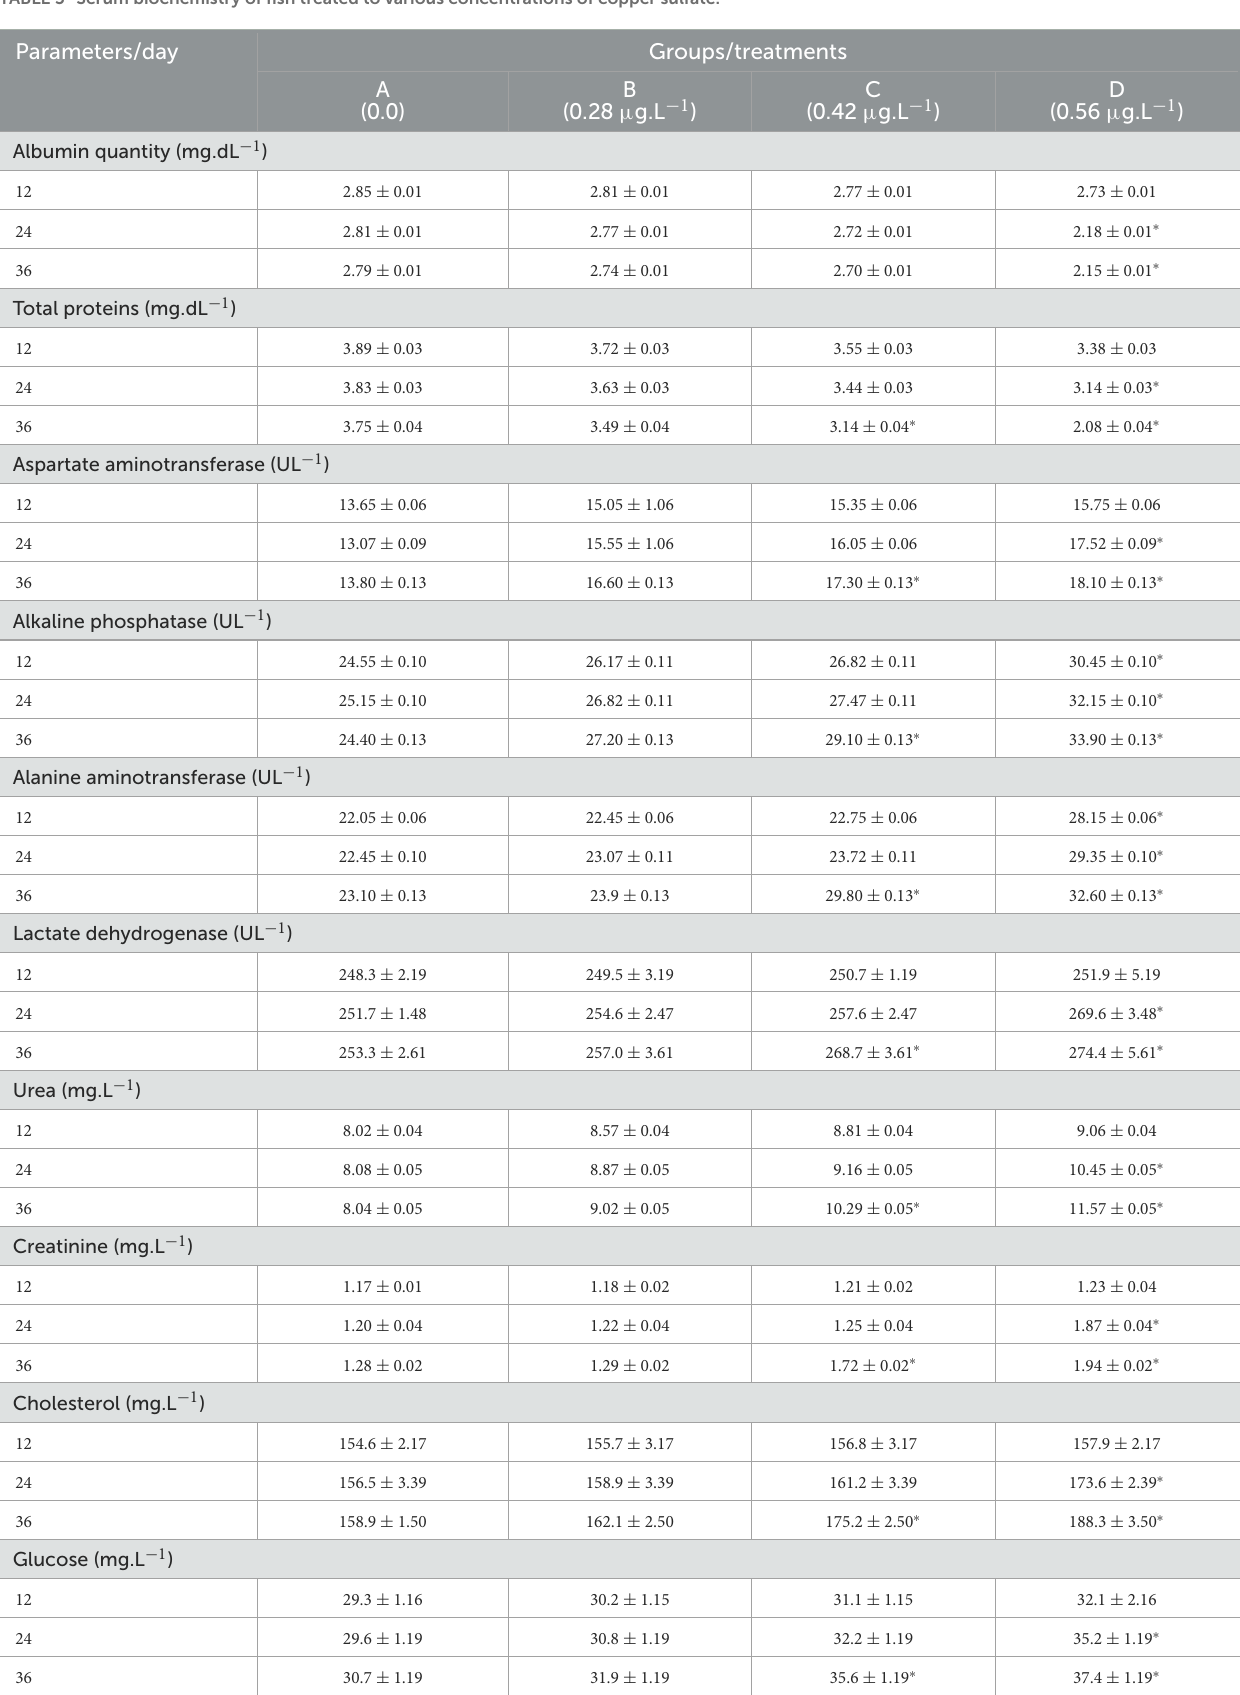
TABLE 5 Serum biochemistry of fish treated to various concentrations of copper sulfate. Parameters/day